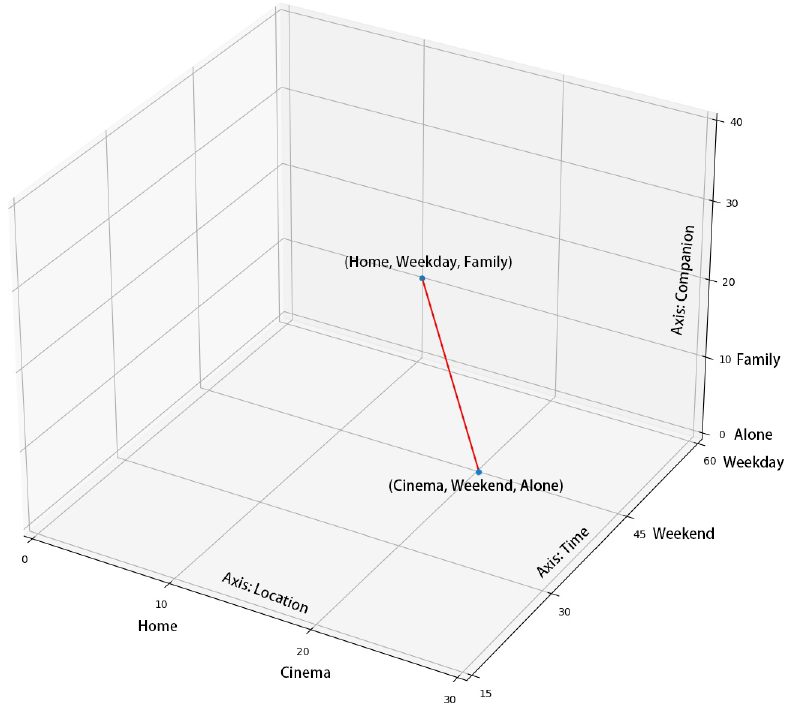
Figure 3. Visualization of multi-dimensional space in